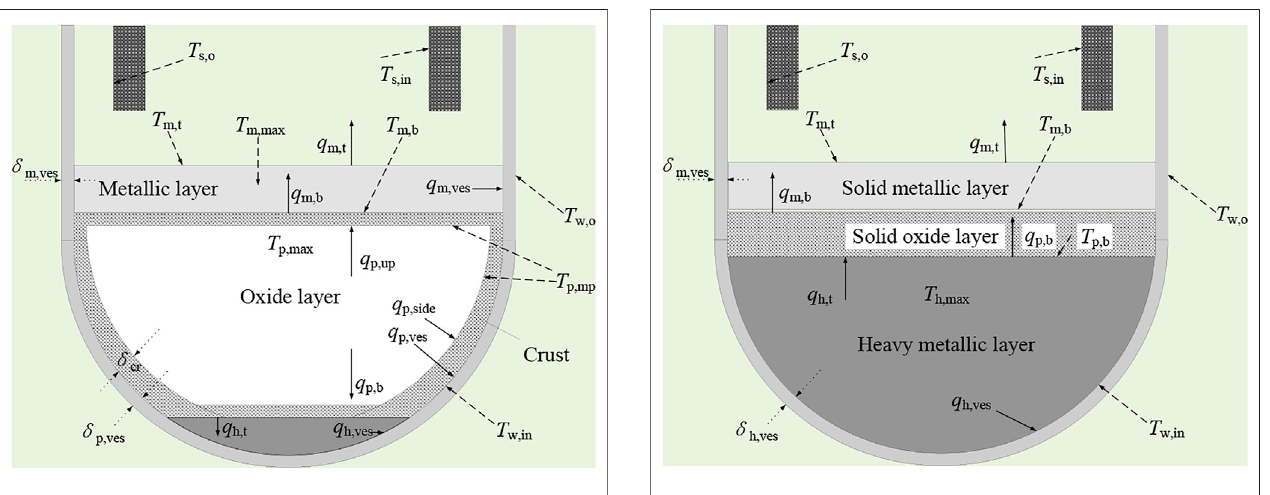
FIGURE 5 | Schematic diagram of thick heavy metallic layers with